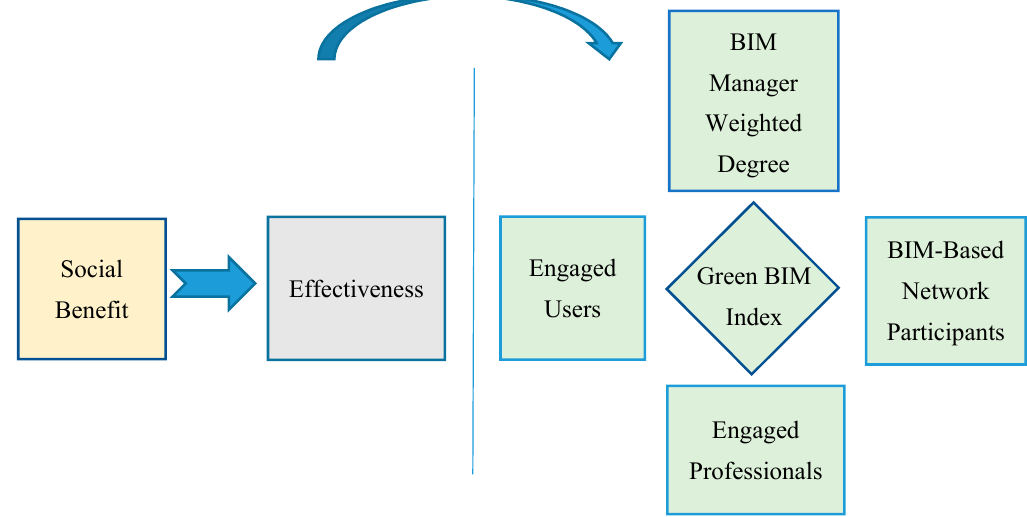
Figure 3. BIM application in terms of social benefit, e ff ectiveness, and the proposed